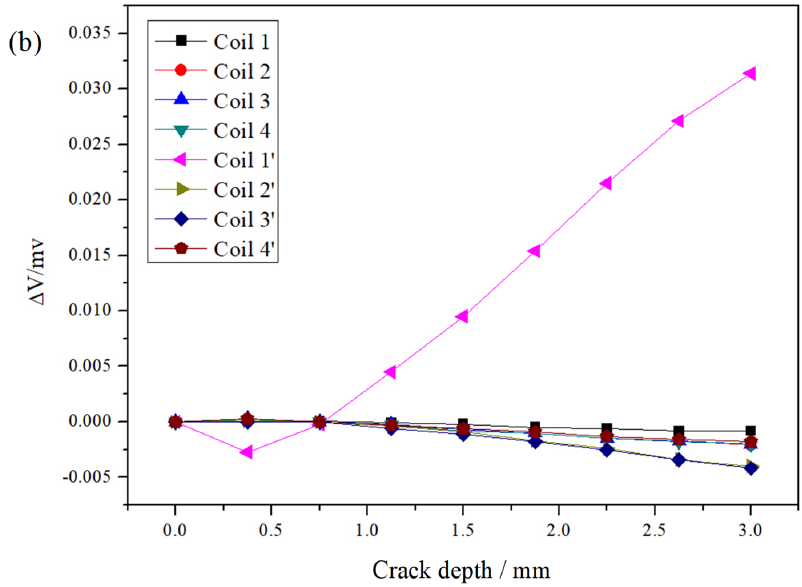
Figure 10. The variation of induced voltage versus the crack depth under different axial locations. ( a ) The crack at the site of Coil 1; ( b ) The crack at the site of Coil 1’.